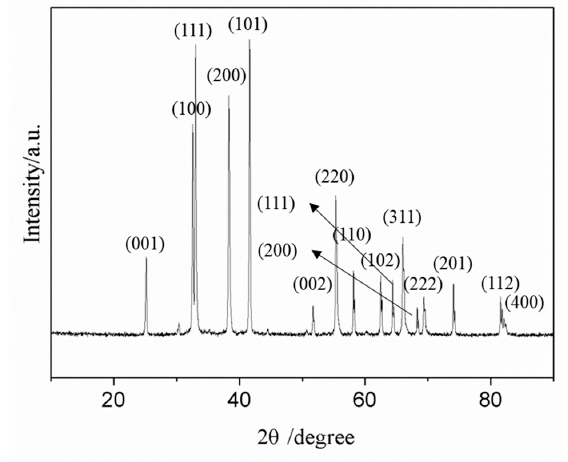
Figure 6. XRD patterns of the samples obtained when the mole ratio of B / Zr was set at 1.0. Table 3. Carbon and oxygen contents with di ff erent mole ratio of C / B /